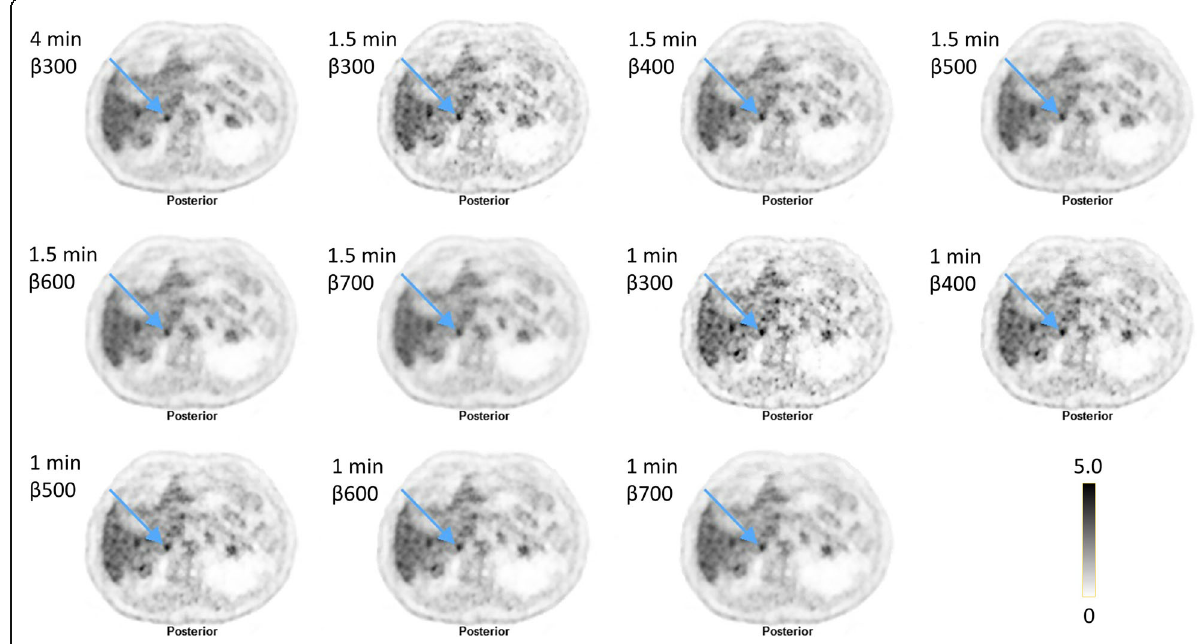
Fig. 4 Example of a lesion (right adrenal gland, indicated by the arrow) and how it appears in the reference with an AT of 16 (4 MBq/kg and 4 min/bed position with a β of 300) and the combinations of time/bed position and β values evaluated